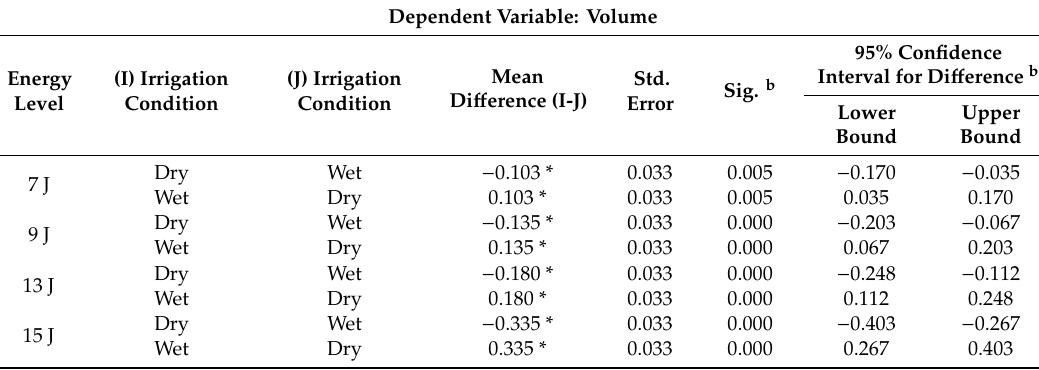
Table A6. Bonferroni-corrected post hoc tests (Irrigation Condition * Energy